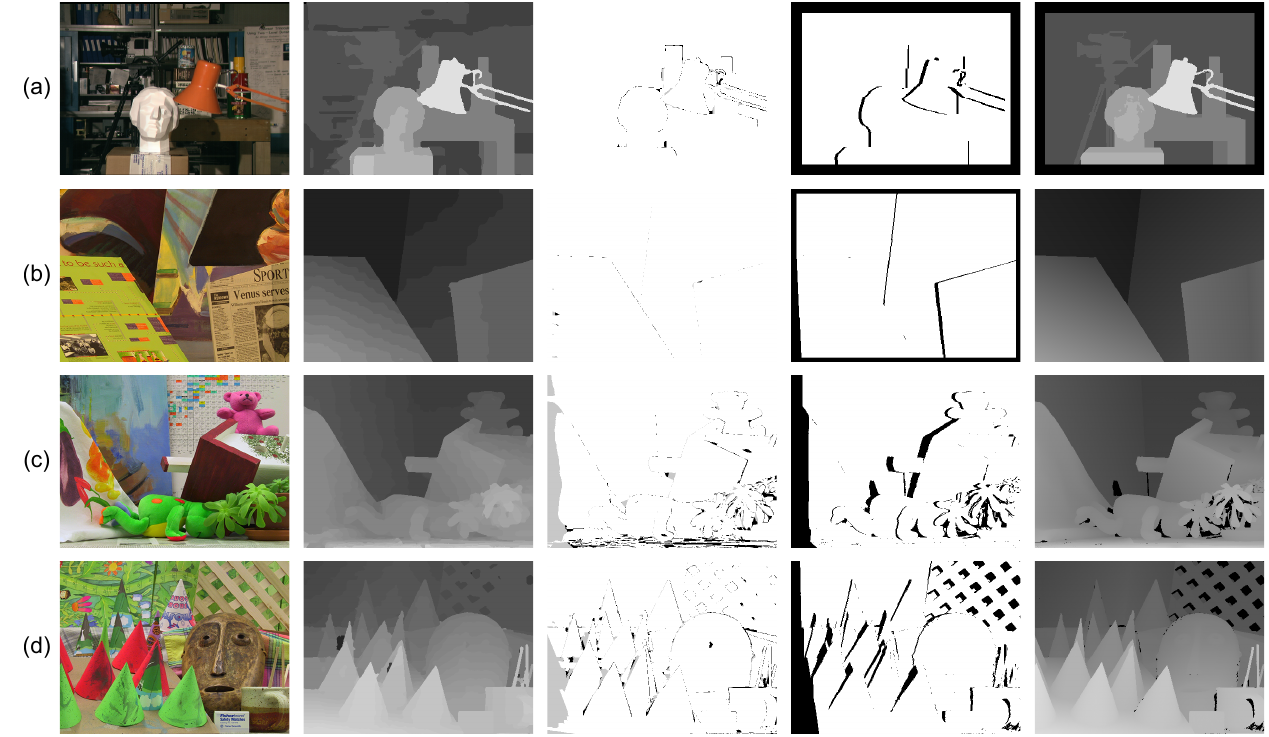
Figure 10. Evaluation results on the Middlebury standard data. ( a ) Tsukuba; ( b ) Venus; ( c ) Teddy; ( d ) Cones. Each row contains (from left to right): the left image, our results, the error map (error matching pixels whose absolute disparity errors are larger than one in non-occlusion and occlusion regions are marked in black and gray), the occlusion map (occluded pixels are marked black) and the ground truth map.